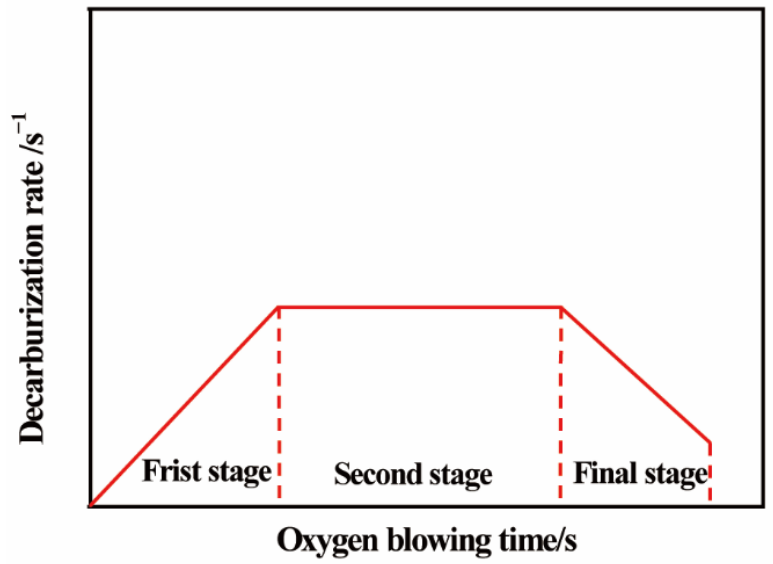
Figure 1. Traditional three-stage decarburization theory for BOF process.